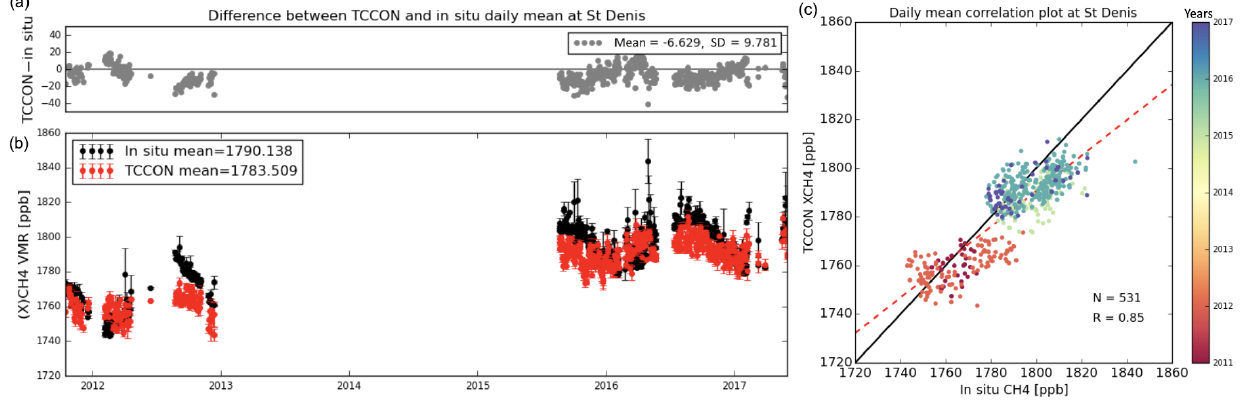
Figure 7. The time series of the daily means and standard deviations from the daytime in situ and FTIR (TCCON) CH 4 measurements at St Denis, in addition to the absolute difference (unit:ppb) between them (left lower and top, respectively) and their correlation (right). Since there is a distinct annual growth for CH 4 , the dots are colored according to the measurement year in the right panel.